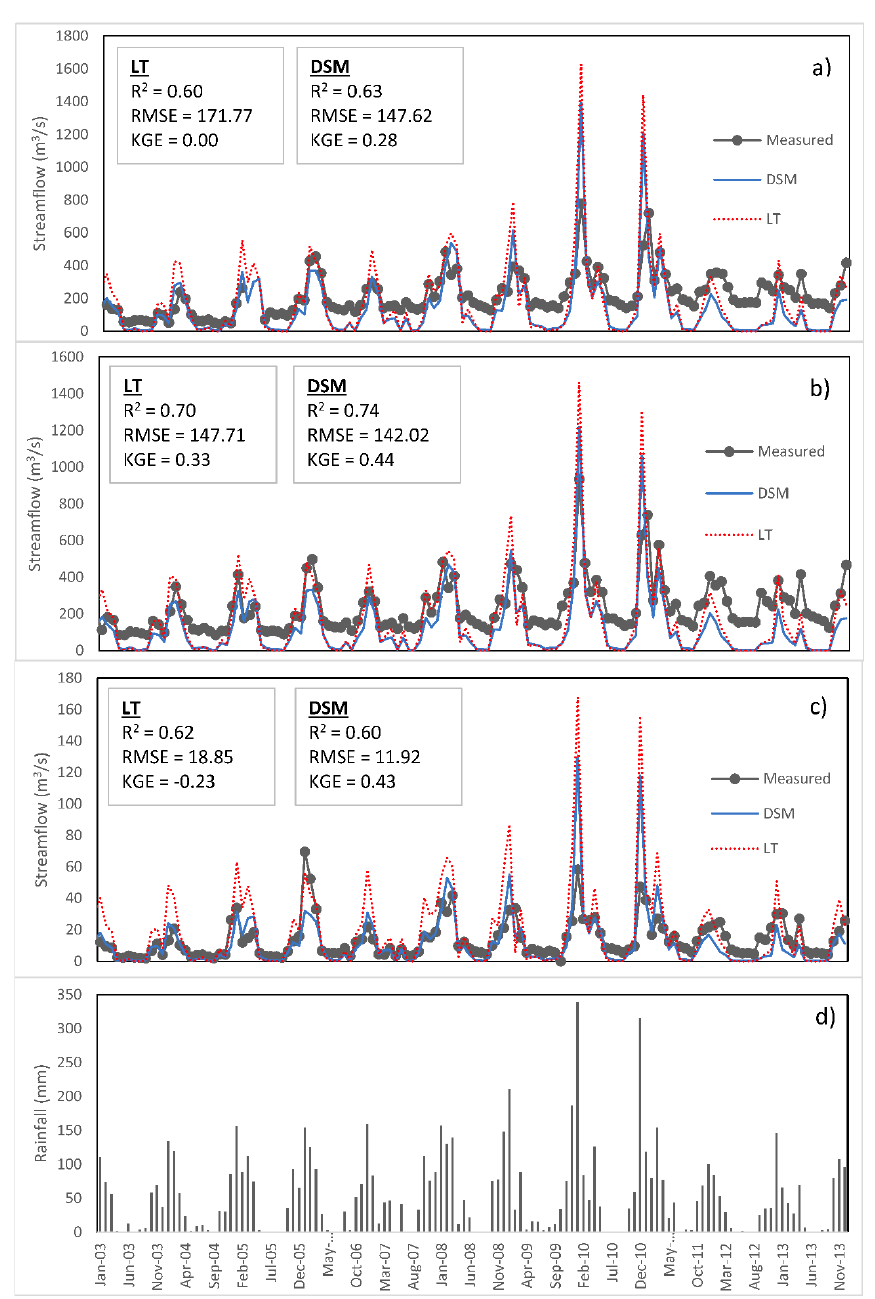
Figure 4. Simulated streamflow for the LT and DSM model runs compared to observed streamflow at the ( a ) A2H044, ( b ) A2H023 and ( c ) A2H047 weirs, respectively, together with ( d ) the rainfall during the validation.